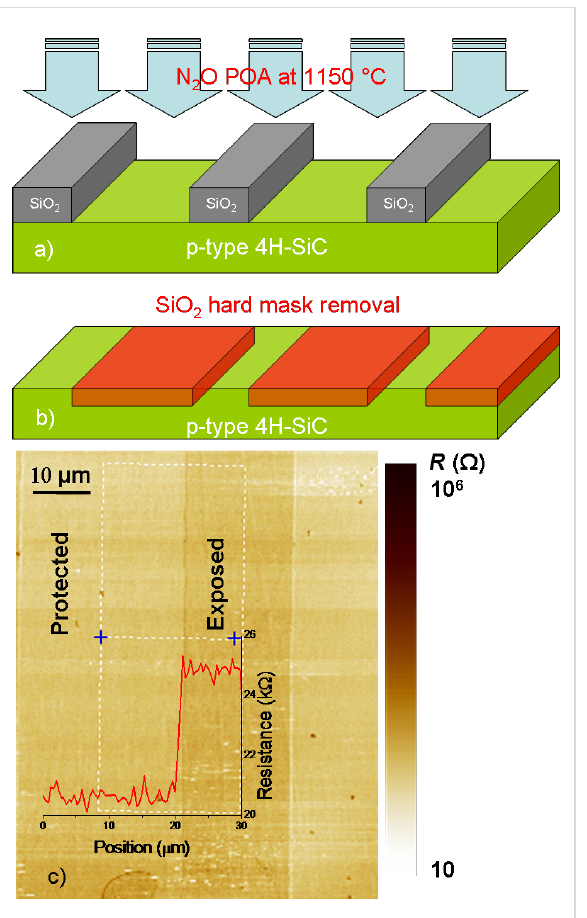
Figure 1: Schematic description of the POA treatment. (a) A SiO 2 hard mask is used to protect selectively the 4H-SiC during the POA. (b) After removal of the hard mask (by HF wet etch) on the 4H-SiC surface there are regions protected and exposed to the POA. (c) SSRM imaged on the patterned SiC surface; the two dimensional map of the substrate surface. The resistance line profile going from protected to exposed strips demonstrates a higher resistance value in the exposed region.